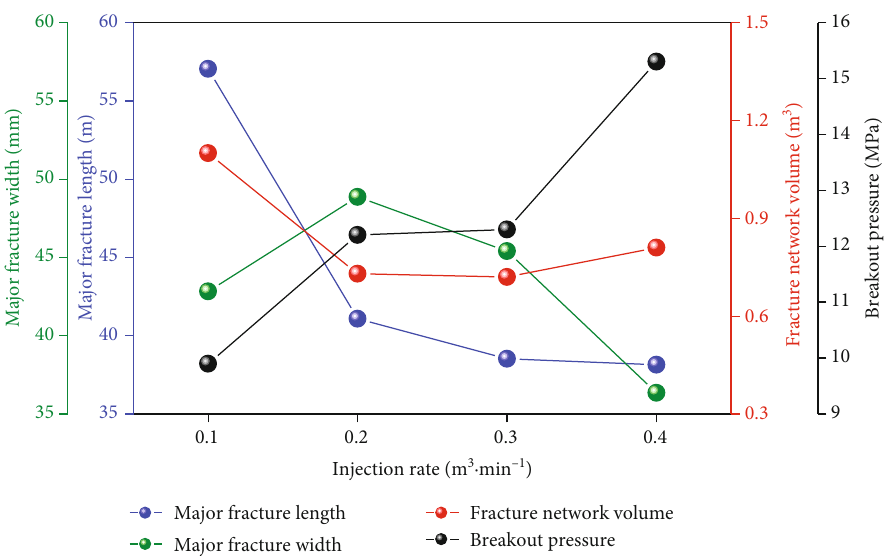
Figure 13: E ff ect of fracturing fl uid injection rate on hydraulic fracture